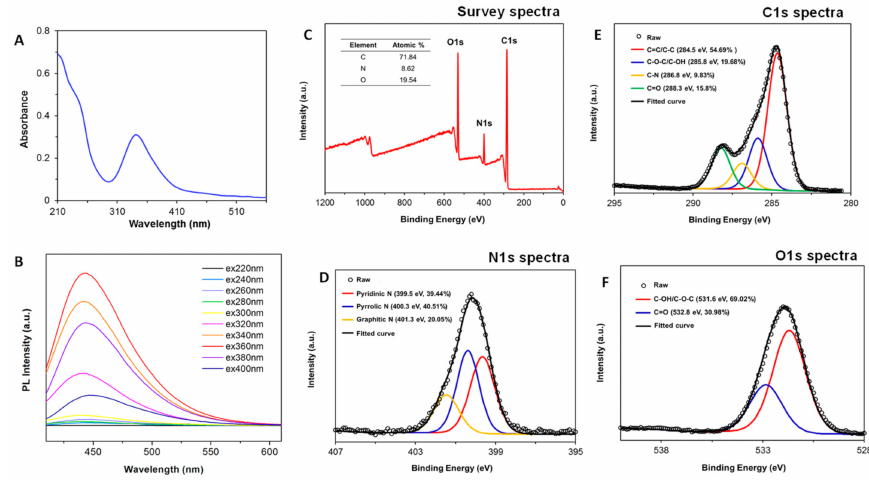
Figure 1. Characterization of CNDs. ( A ) Absorption spectrum. ( B ) CNDs show emission peak of ≈ 450 nm with excitation wavelengths from 220 to 400 nm. ( C – F ), X-ray photoelectron spectrum signals.